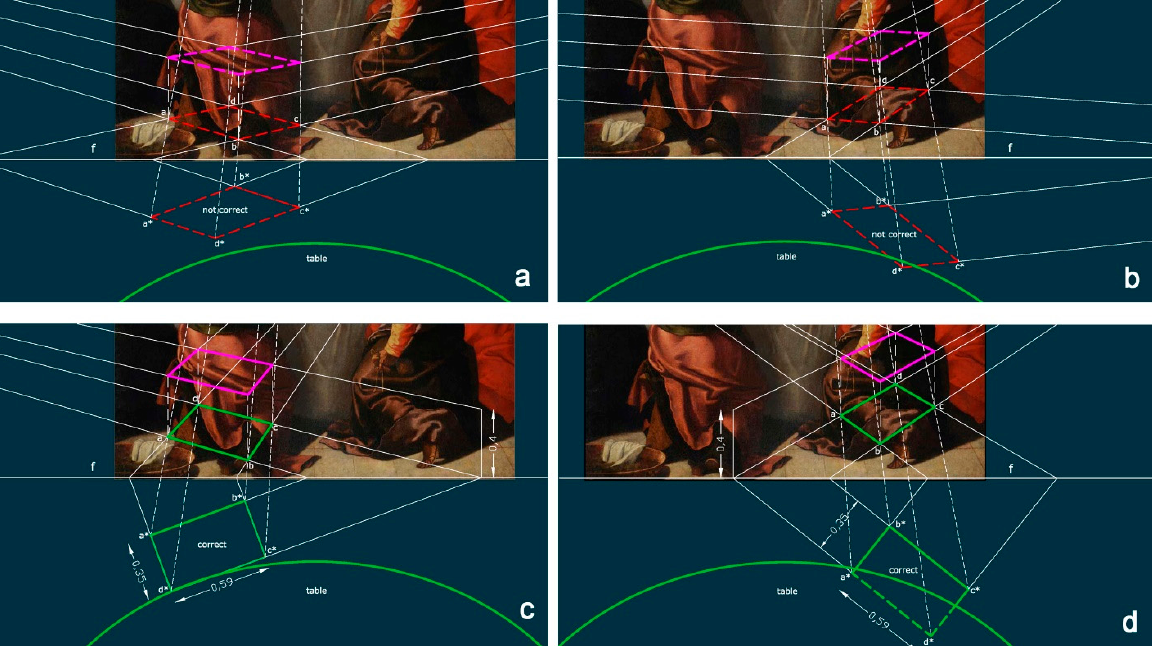
Figure 7. ( a ) Perspective restitution of the left stools according to the painter’s perspective; ( b ) perspective restitution of the right stools according to the painter’s perspective; ( c ) perspective restitution of the left stools according to the correct perspective; ( d ) perspective restitution of the right stools according to the correct perspective.